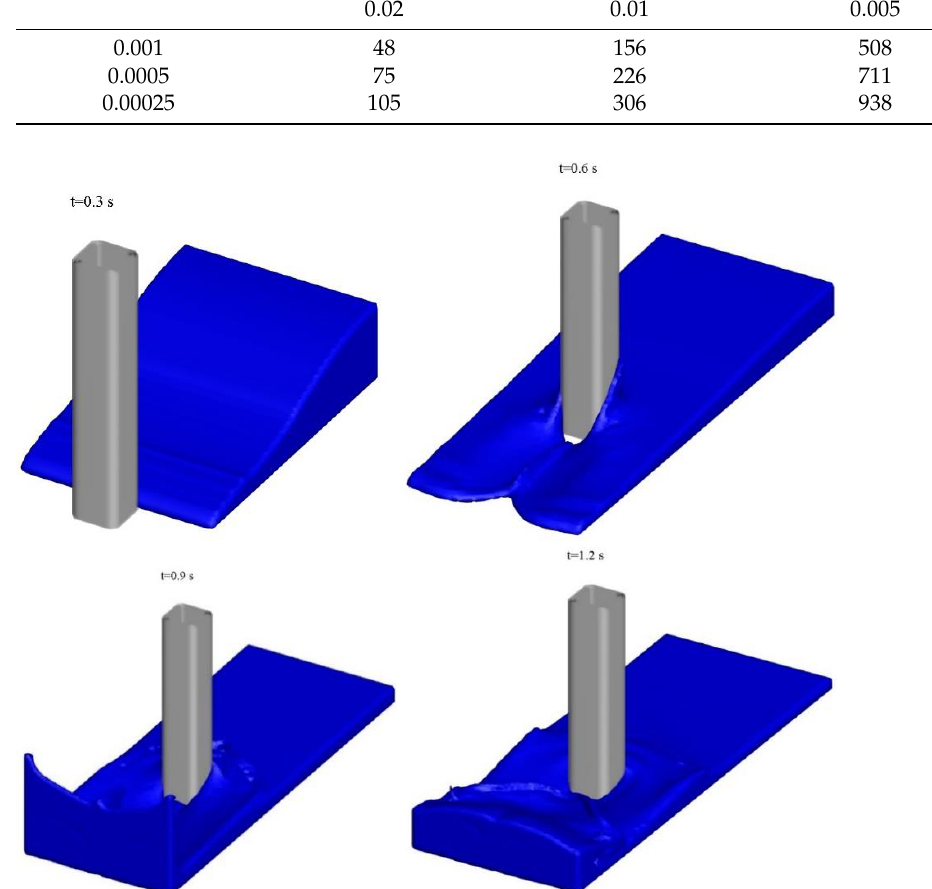
Figure 3. Simulation of three-dimensional dam-break flows over a vertical square cylinder.